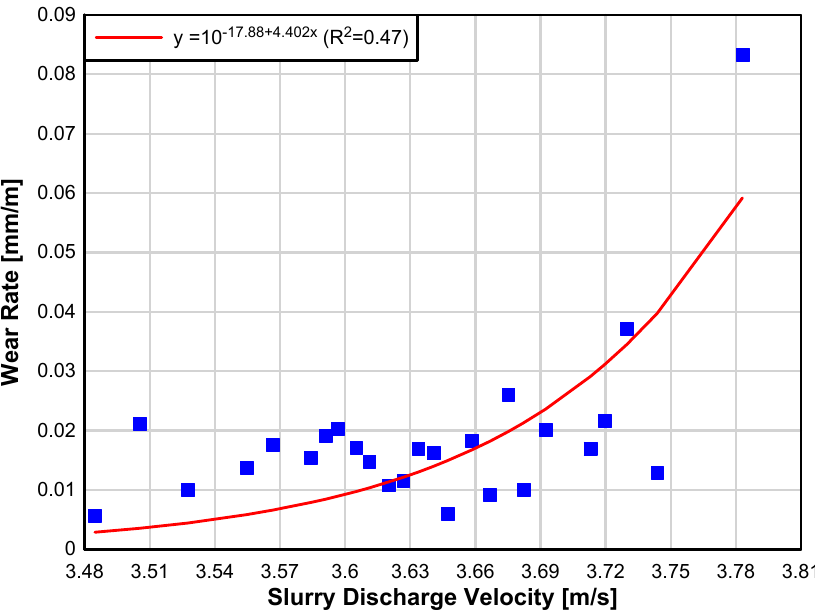
Figure 12. Relationship between the slurry discharge velocity and the wear rate.